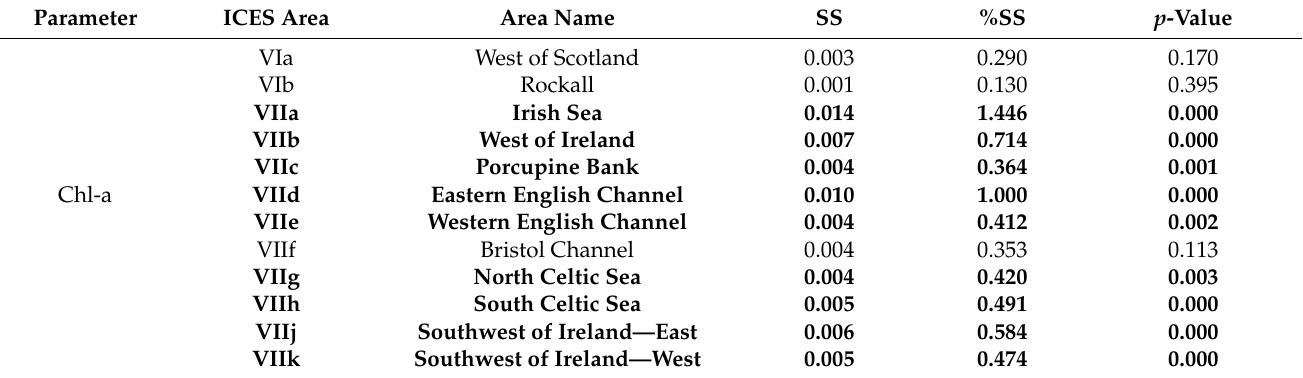
Table 2. Chl-a trend values resulting for each ICES division. SS—Sen slope (mg/m 3 /year), %SS